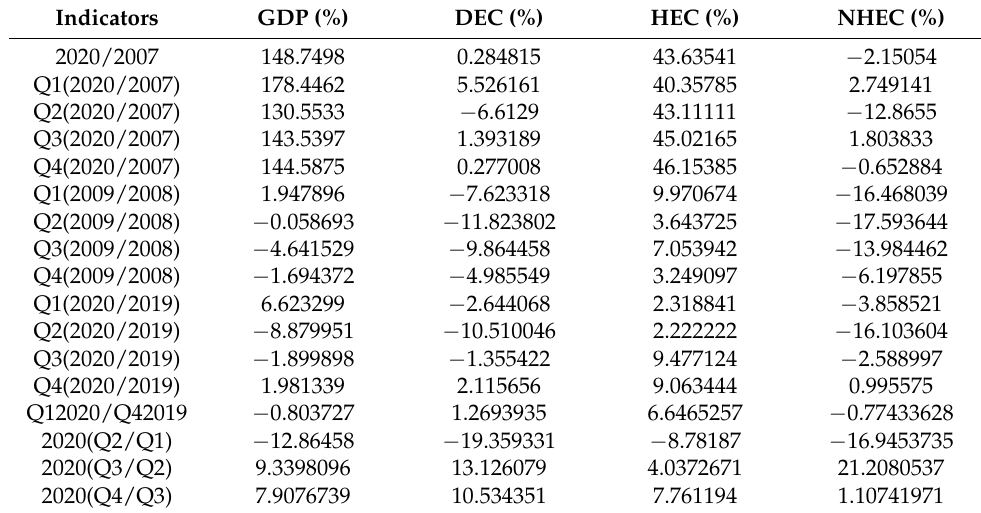
Table A2. Analysis of the quarterly and annual evolution of the